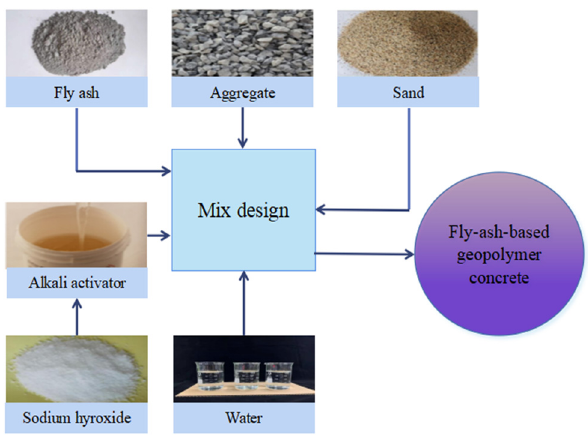
Figure 1: Preparation process of fl y ash - based geopolymer